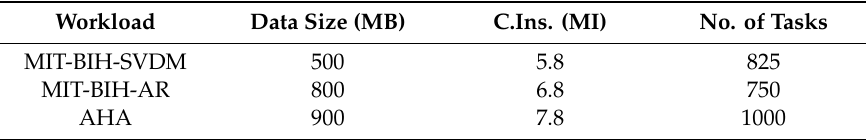
Table 5. Heartbeat datasets